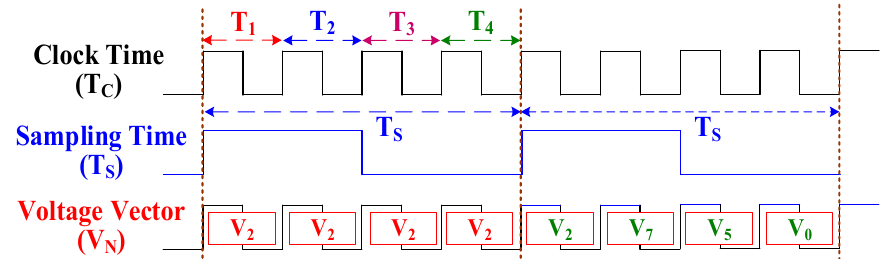
Figure 9. Time sequence of the MDMVV for the stator torque.